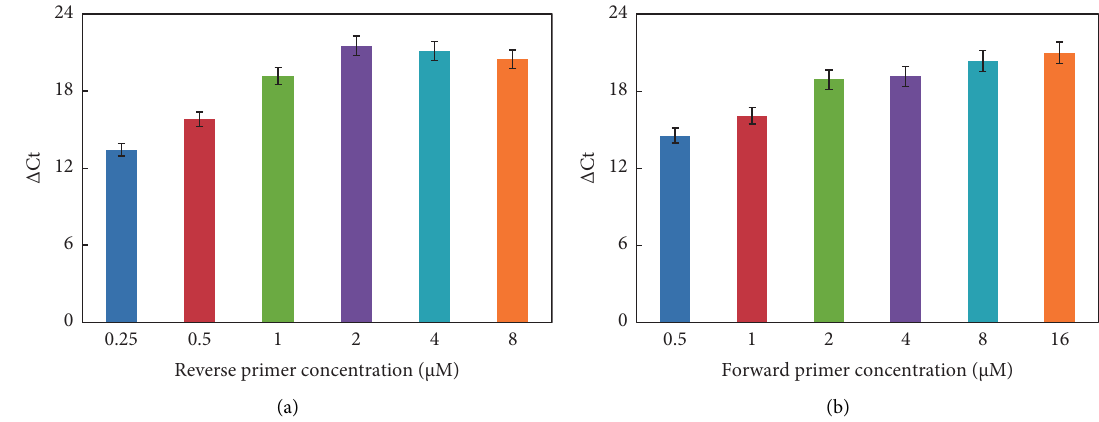
Figure 4: △ Ct value vs the amount of reverse (a) and forward (b) primer concentration. Experiment conditions: (a) miRNA was 1nM; forward primer was 4 μ M; mediator template was 50nM; and Tm was 42 ° C; (b) miRNA was 1nM; reverse primer was 2 μ M; mediator template was 50nM; and Tm was 42 ° C. The detection procedure was carried out as described in the experiment section.